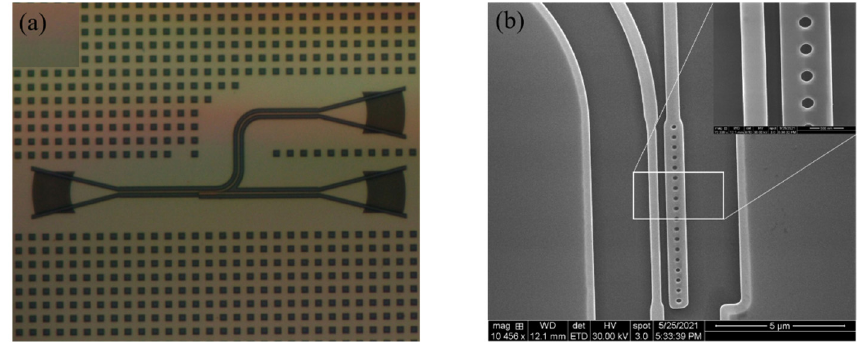
Figure 7. ( a ) Microscope image of the chip under test and ( b ) SEM image of the fabricated device.